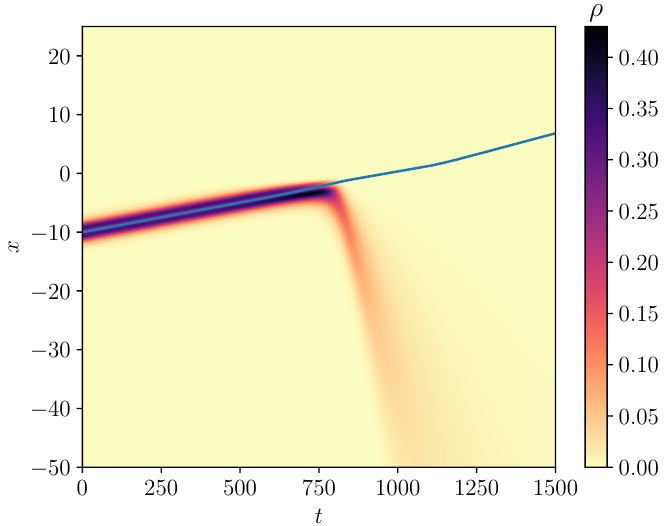
Figure 8 . Evolution of the fermion number density in spacetime as the antikink crosses the spectral wall. The fermion is reflected by the wall and decouples from the kink. The negative energy fermion is in the first excited state. β = 46 . 0 .